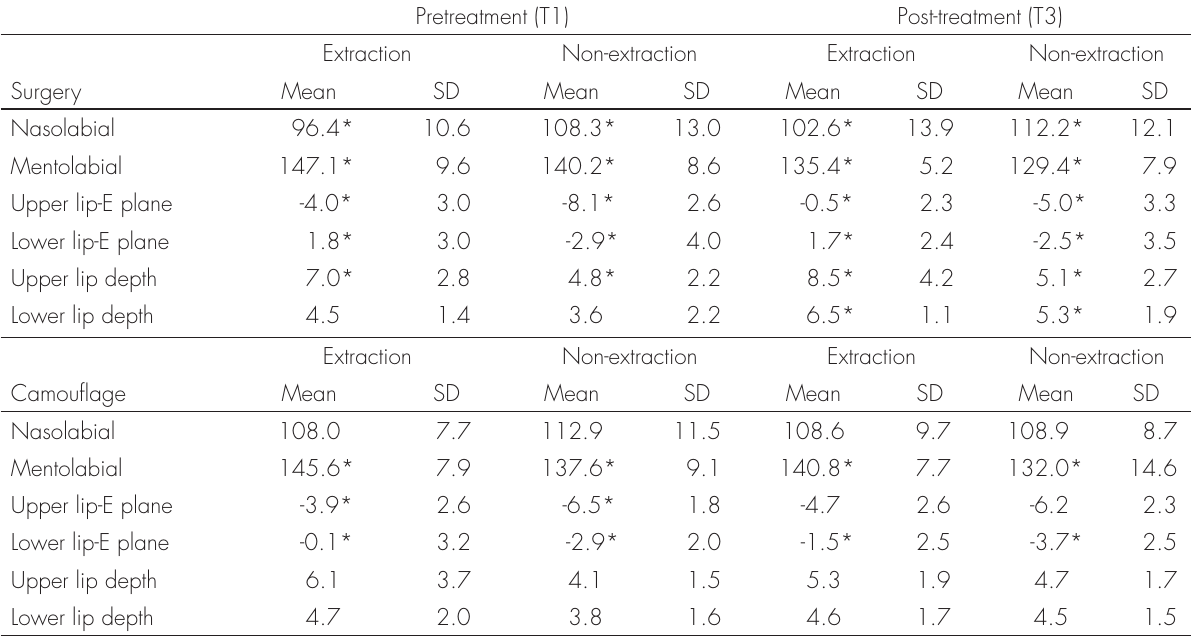
Table V. Cephalometric soft tissue characteristics of extraction and non-extraction